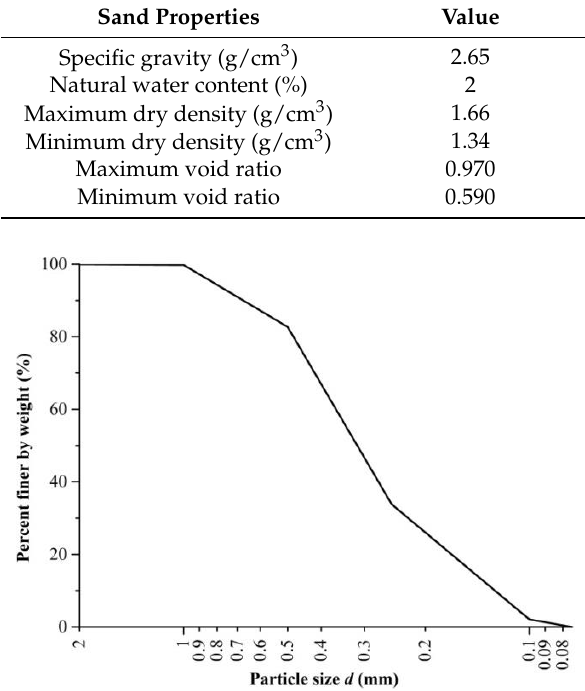
Figure 1. Grain size distribution of sand.